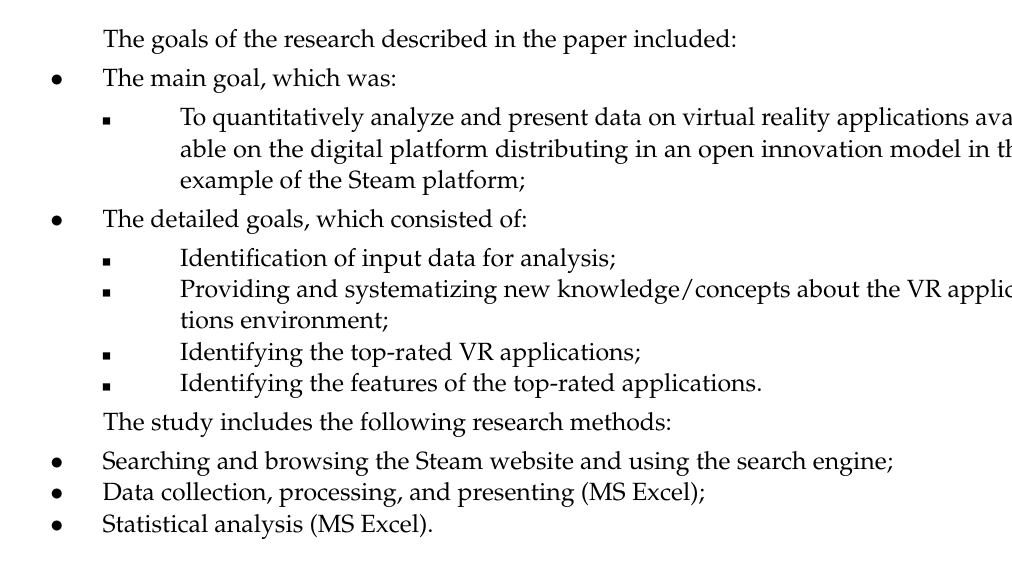
Figure 1. The number of Steam users—data on 5–6 July 2022 [accessed: 6 July 2022, 3:44 p.m. (GMT+2:00) Warsaw], source of Figure: [35].